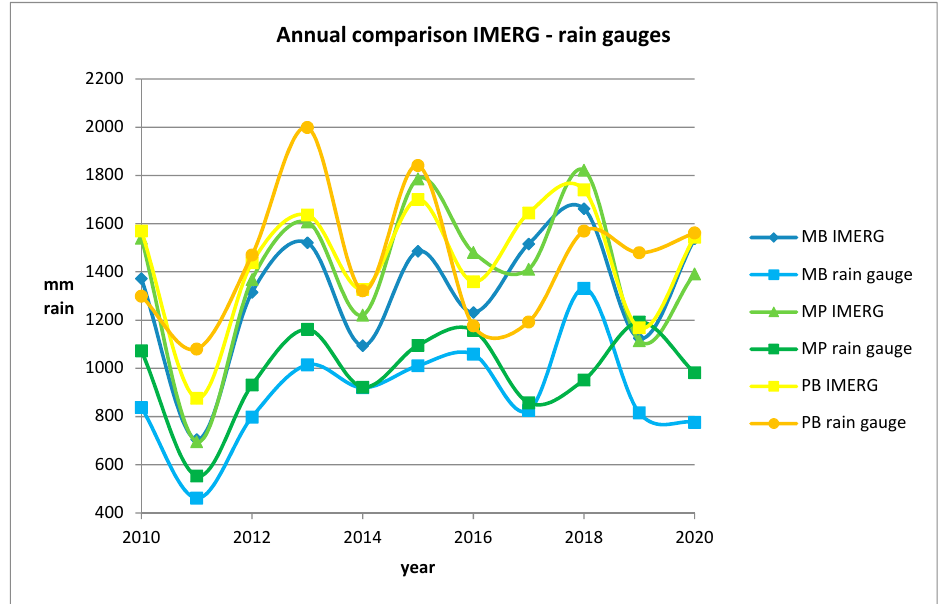
Figure 2. Annual comparison between IMERG data and rain gauge data at the same locations: MB (Monte Bove), MP (Monte Prata), PB (Pintura di Bolognola).